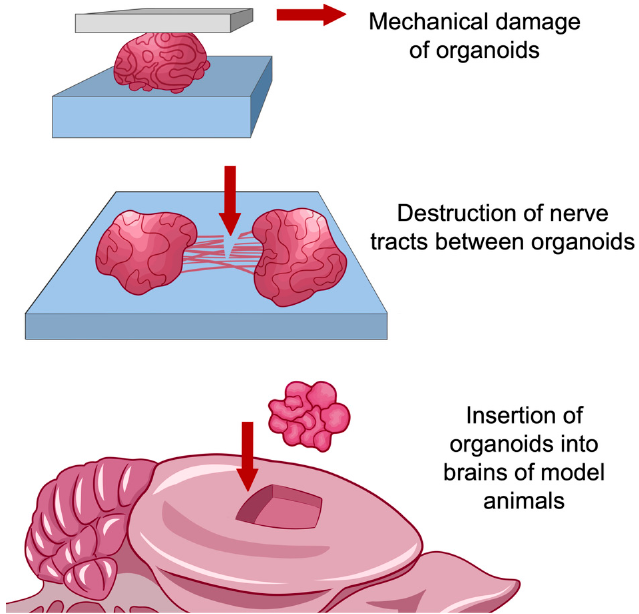
Figure 3. Scheme of possible use of organoids for modeling and potential treatment of traumatic brain injuries. Organelles can be used as separate systems, as interconnected units, and as part of model animal organisms.